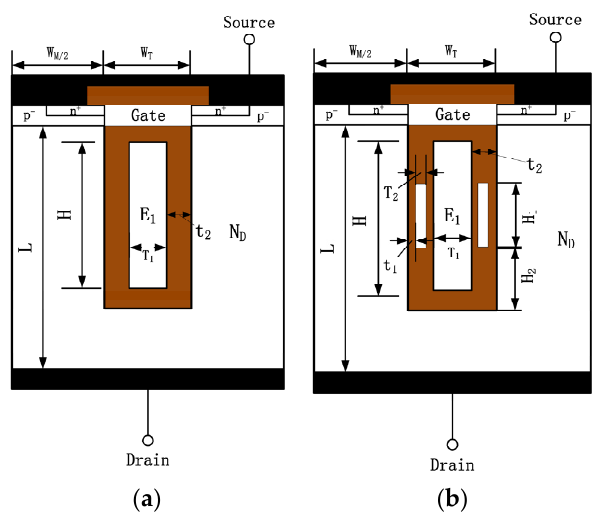
Figure 1. Schematic cross section of ( a ) SGRSO and ( b ) DFSGRSO UMOSFETs.